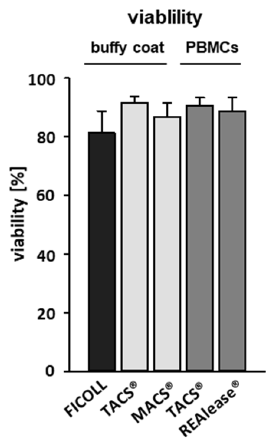
Figure 4. Effect of the different CD3-dependent isolation methods on cell viability. CD3-positive cells were either separated from buffy coats by the MACS ® and TACS ® system or from Ficoll purified PBMCs by the TACS ® and REAlease ® system. After separation, cells were cultured (1 × 10 6 /mL) for six days in medium. The viability of the cells was determined via flow cytometry by using Fixable Viability Dye FVD eFlour ® 780 after incubation. Shown are the percentages of viable cells negative for FVD eFlour ® 780 ± SD, n = 4.